Question: What style of plot is this figure drawn as?
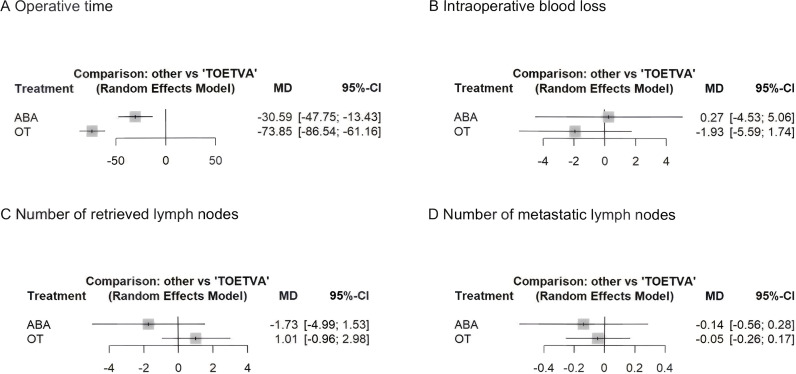
Answer: forest